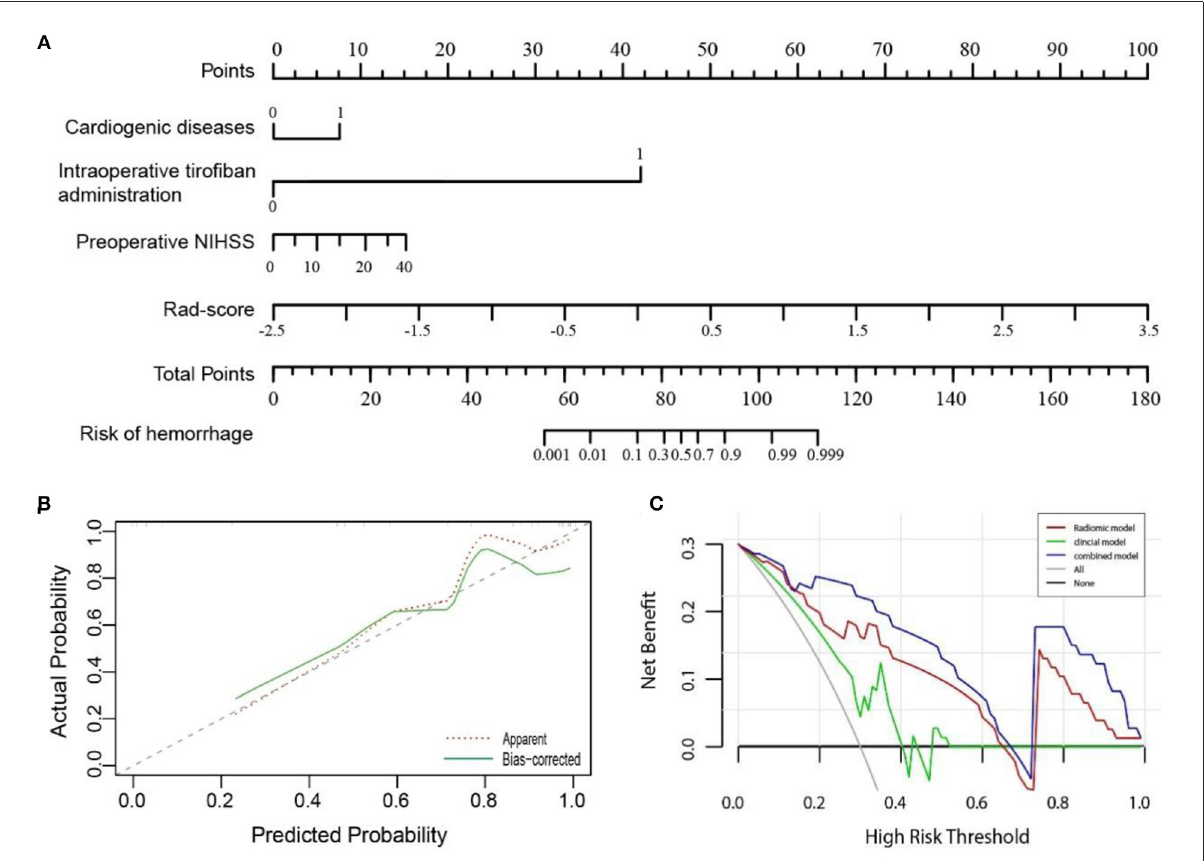
FIGURE4 (A) A nomogram showing the probability of hemorrhage in hyperdense areas was developed based on the combined model, incorporating into four variables: cardiogenic diseases, intraoperative tirofiban administration, preoperative NIHSS, and Rad-score. (B) Calibration curve of the nomogram in the validation cohort. The dashed line was a reference line indicating an optimal nomogram. (C) Decision curve analysis for three models in the validation cohort. The y-axis indicates the net benefit; x-axis indicates threshold probability. The blue line, red line, and green line represent net benefit of the combined, the radiomic, and the clinical model, respectively. The combined model had the highest net benefit compared with the other two models across the full range of threshold probabilities at which a patient would be diagnosed as hemorrhage.